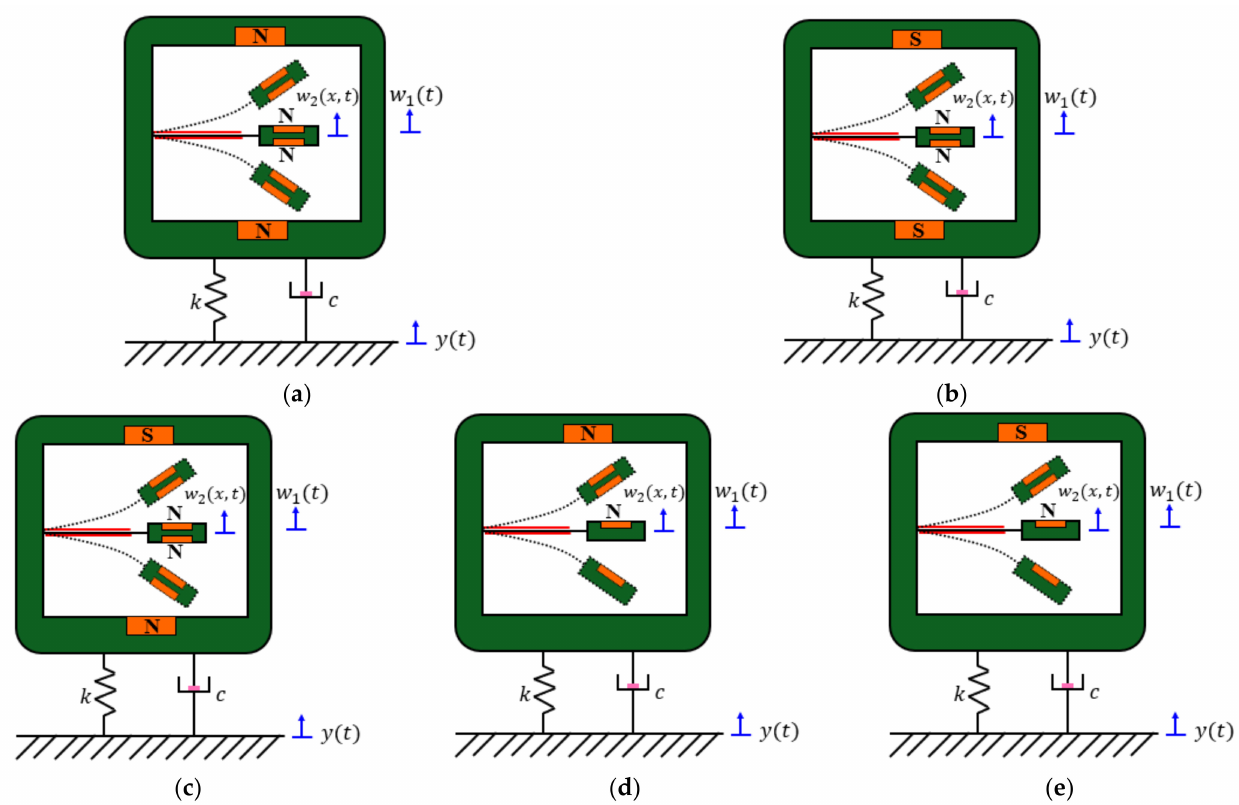
Figure 1. A representation of the coupled system under investigation with two magnet constraints with ( a ) repulsive and ( b ) attractive configurations that generate neutral static positions. Configura- tions that generate a change in static position are ( c ) two magnet constraints with opposite polarities and single magnet constraints of ( d ) repulsive and ( e ) attractive